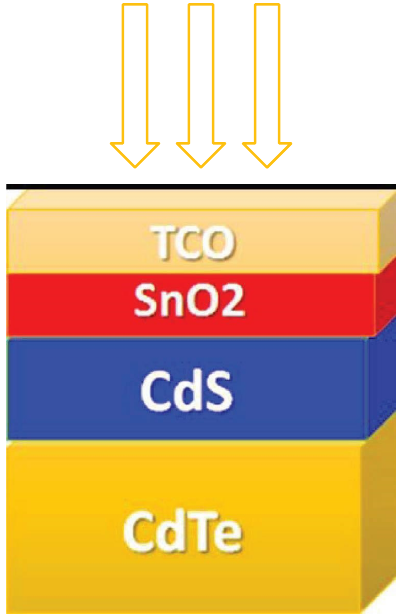
Figure 1: Engineered and simulated solar cell Table 1: Parameters used in solar cell simulation [9].